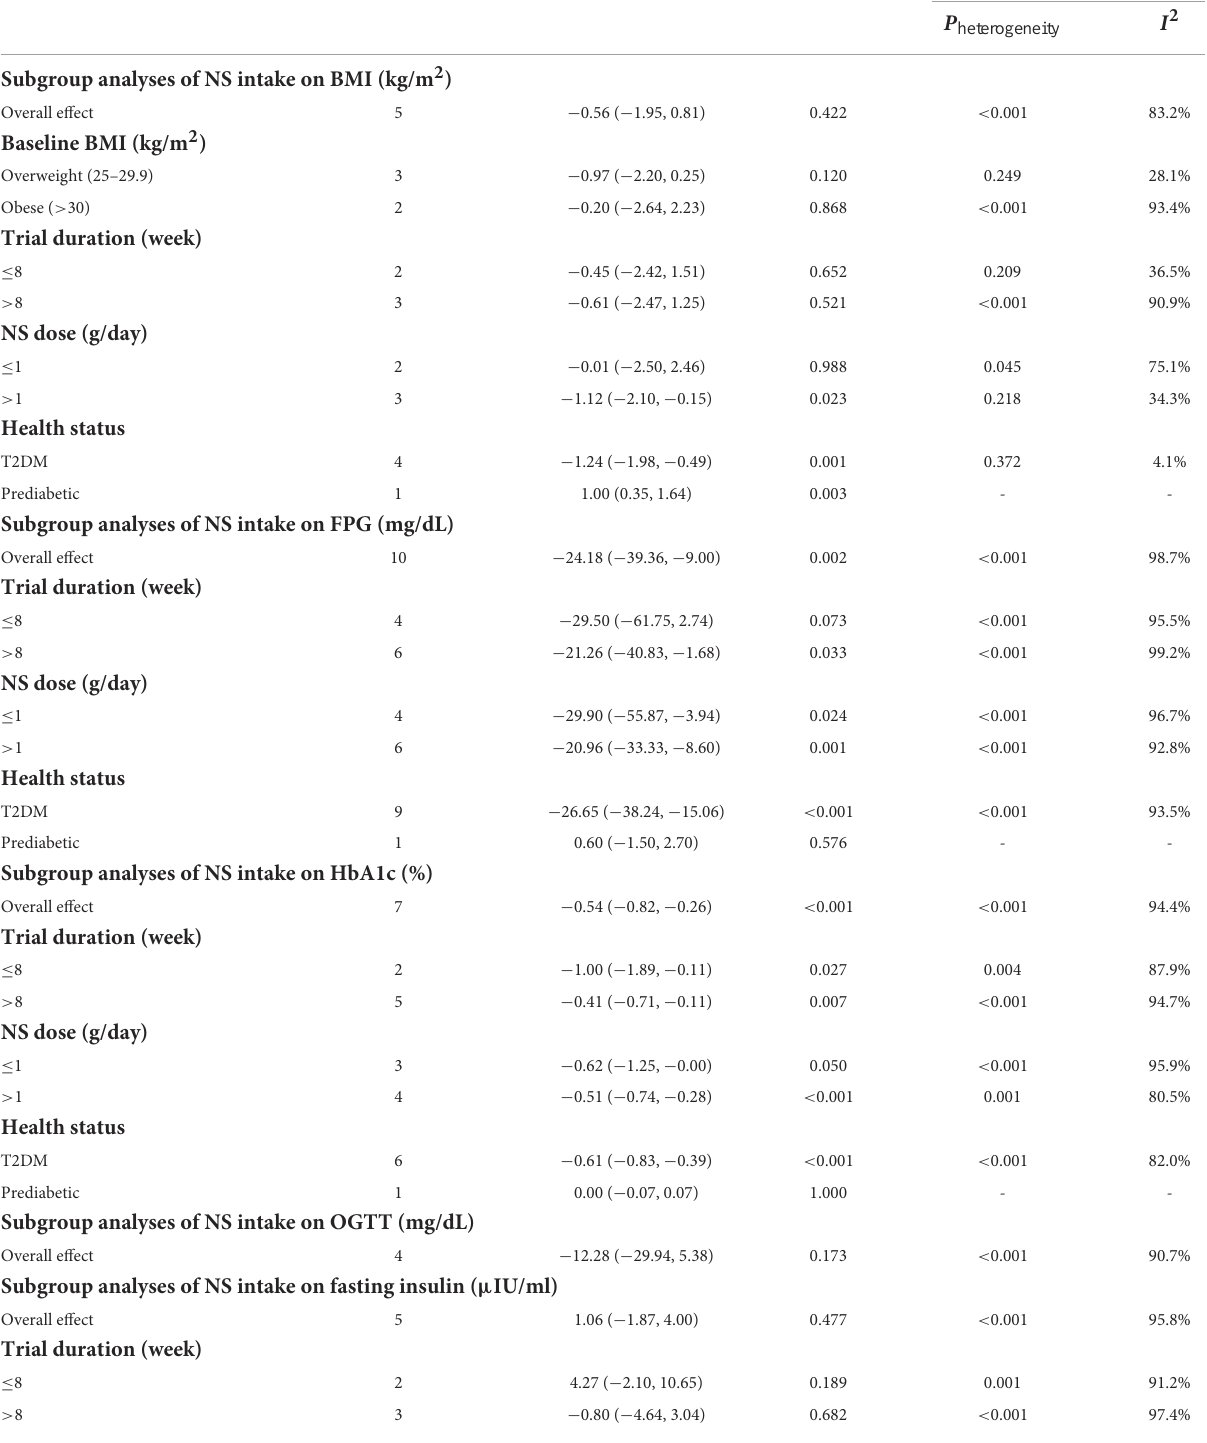
TABLE 3 Subgroup analyses of NS intake on body mass index, glycemic indices, lipid profile, CRP, and MDA. Number of studies WMD (95%CI) P -value Heterogeneity